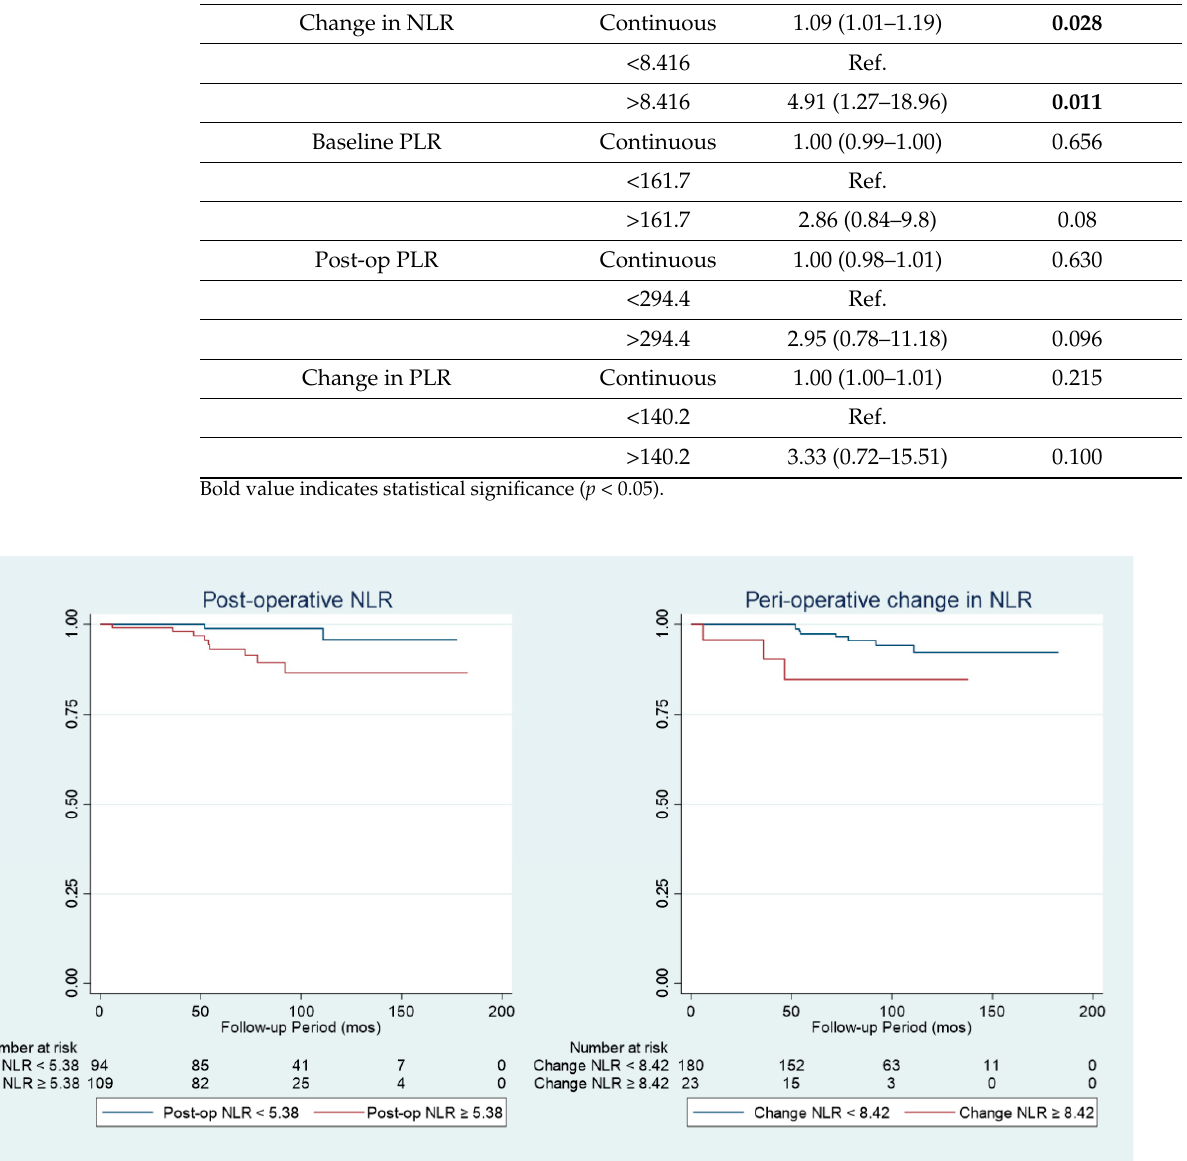
Figure 3. Kaplan–Meier graphs outlining the association of NLR with LRFS. However, in multivariate analysis, all NLR and PLR factors were not found to be associated with LRFS (Table 6). Table 6. Multivariable analysis of NLR and PLR for local-recurrence free survival.